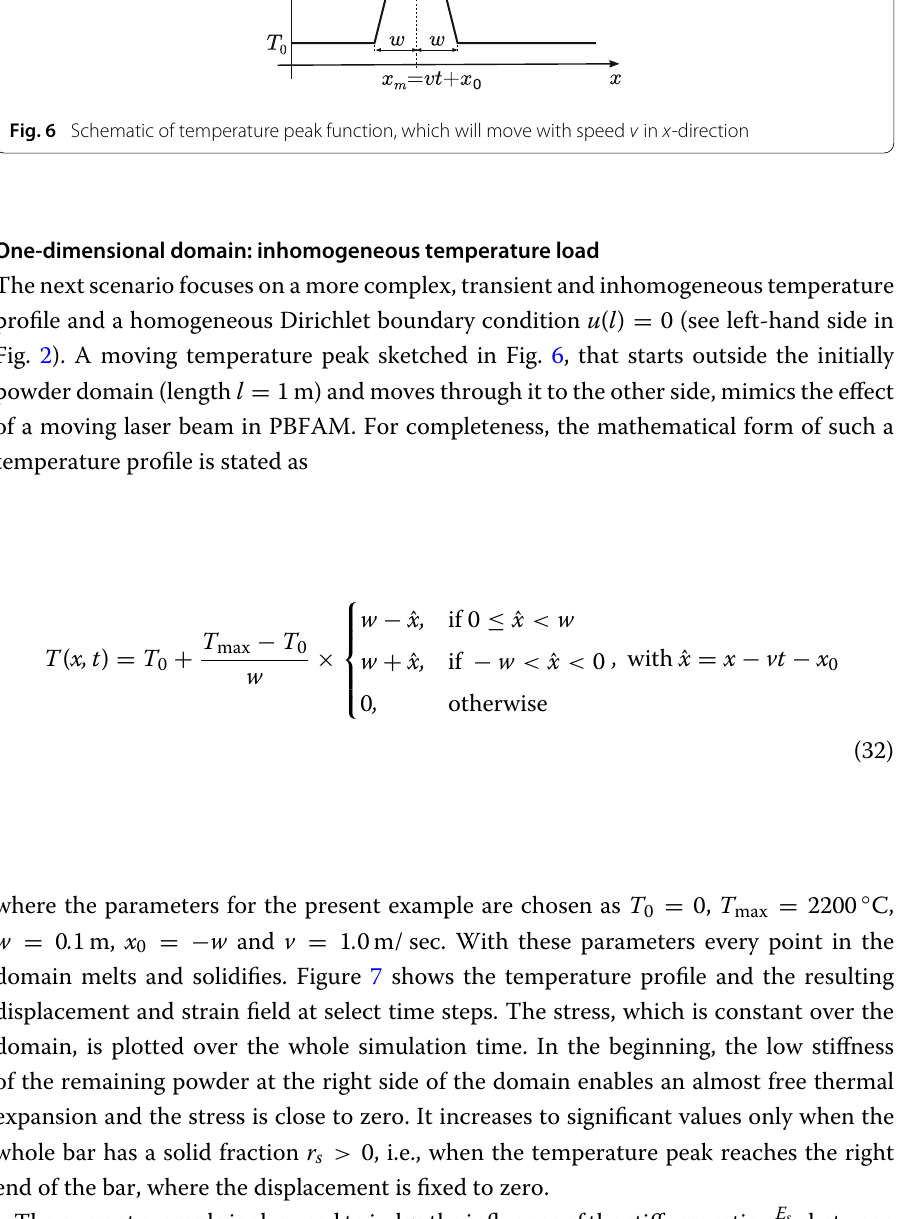
Fig. 6 Schematic of temperature peak function, which will move with speed v in x -direction